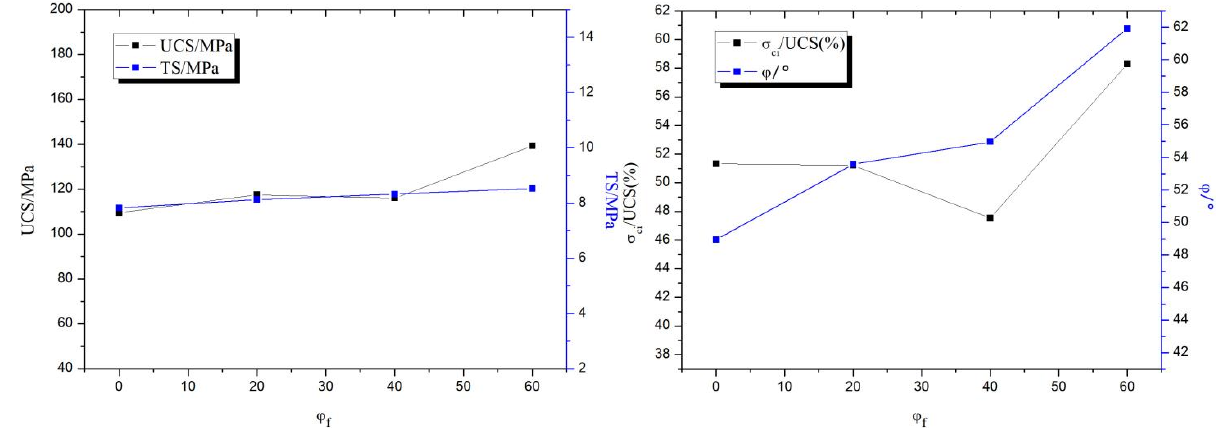
Figure 6. Average value of microscopic parameter results.